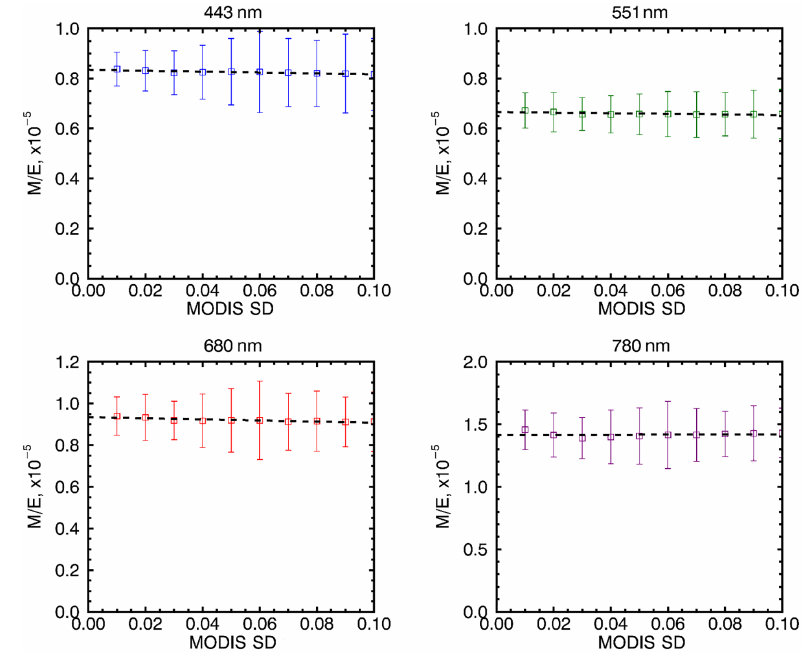
Figure 5. MODIS/EPIC ratios for the four spectral channels binned according to the MODIS relative standard deviation and MODIS reflectance > 0 . 6. Whiskers show mean and the standard variation of the ratios in each bin. Straight lines show linear regressions. EPIC Version 2 data are used. The resulting gain coefficients are 0.835 for the 443nm channel, 0.666 for the 551nm, 0.934 for the 680nm and 1.41 for the 780nm channel.